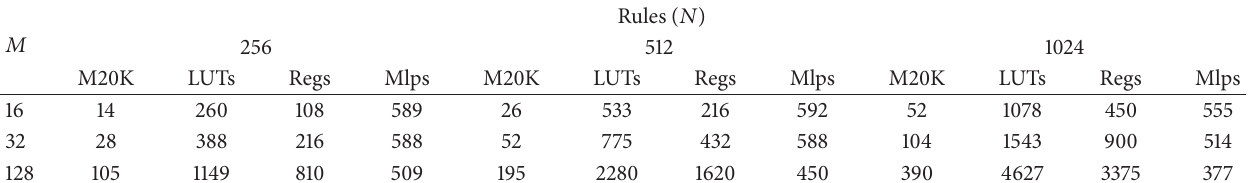
Table 4: Performance of IND, horizontal BV-stitching, and 2D-pipelined architecture on FPGA ( 𝑚 = 9 , 𝑛 = 40 ).